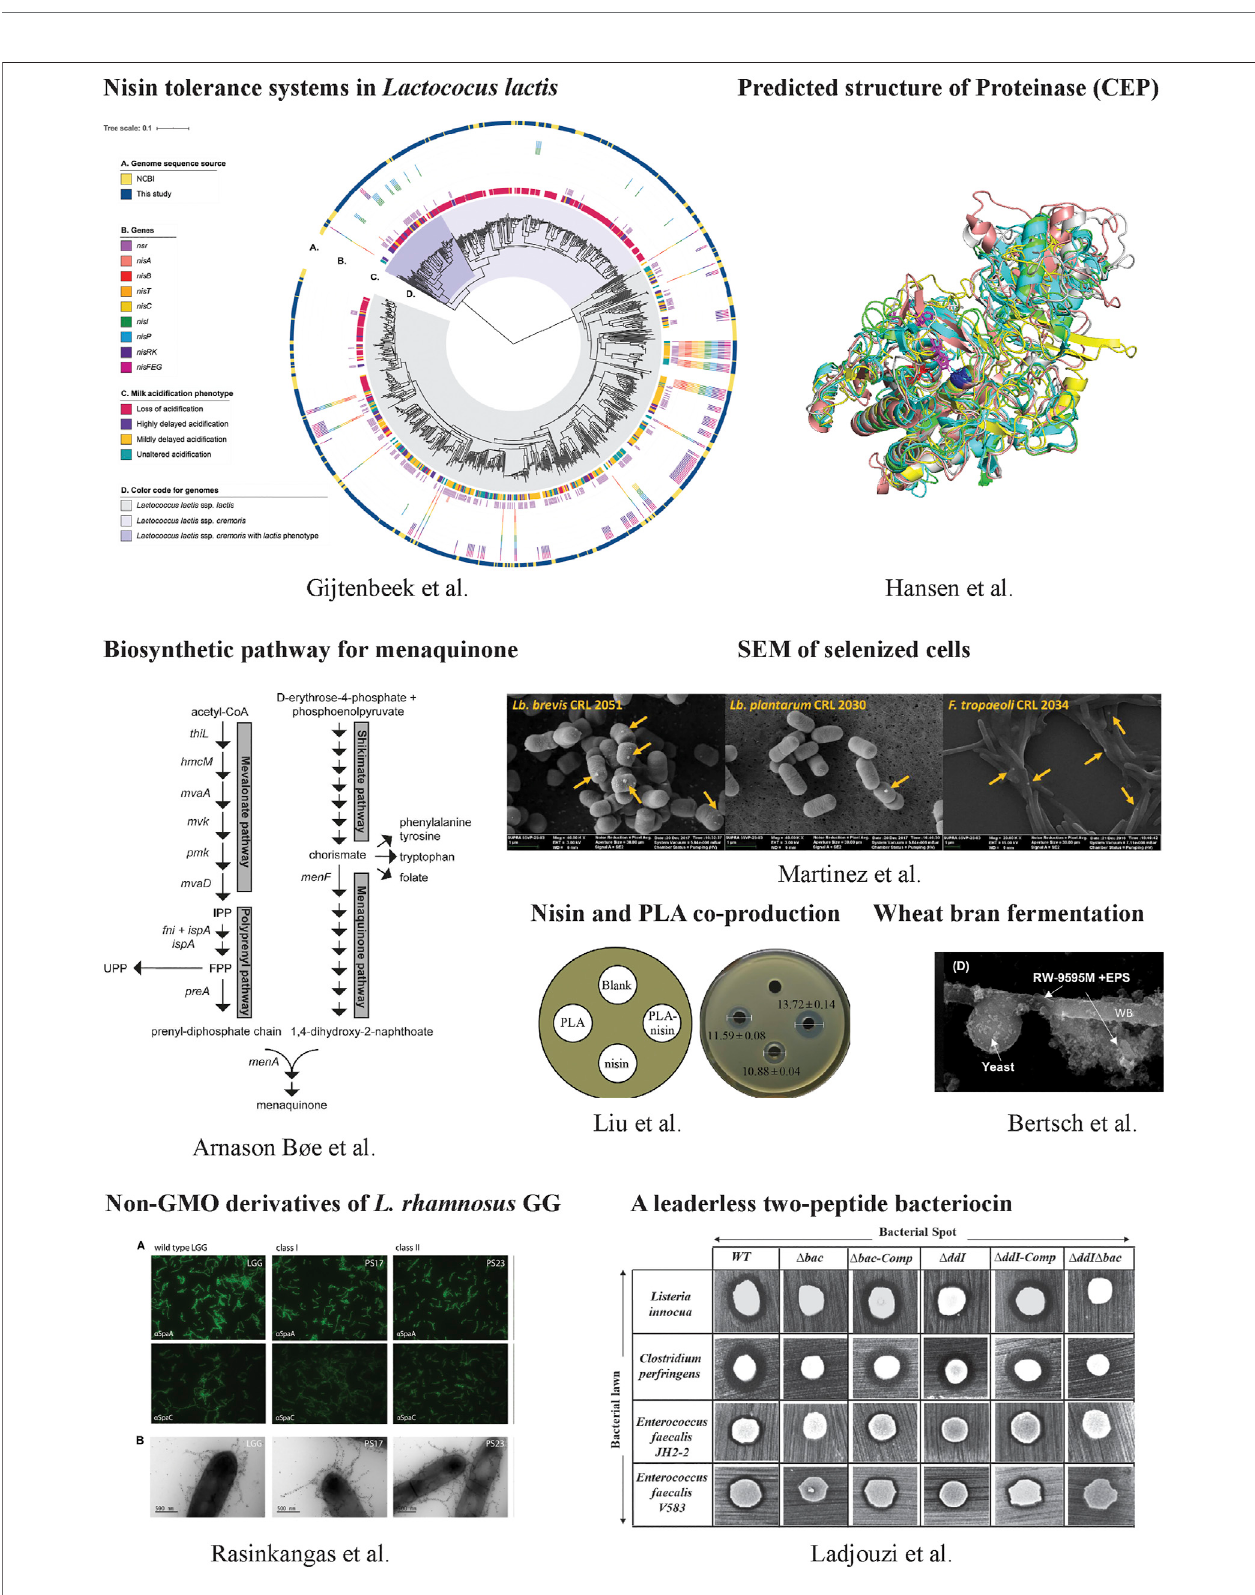
FIGURE 1 | Some representative works in this collection.